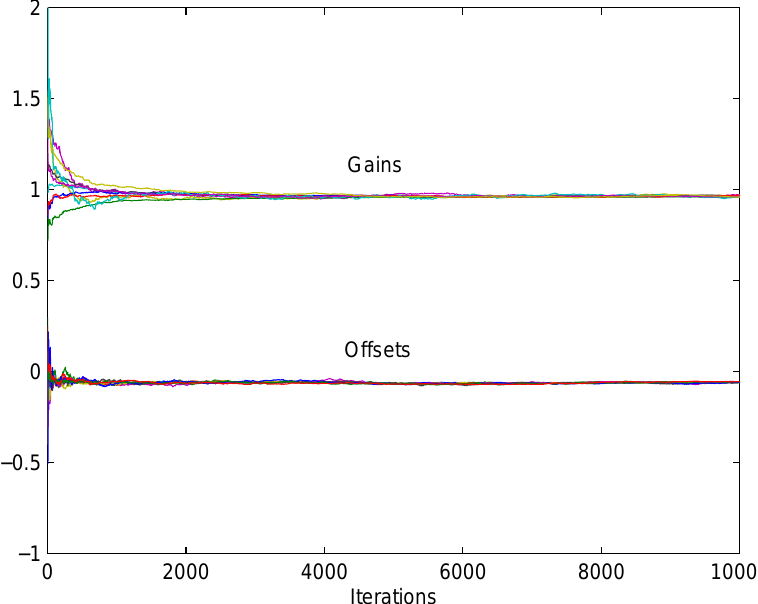
Figure 5. The modified algorithm (25): convergence to consensus is achieved for corrected gains and corrected offsets despite measurement noise